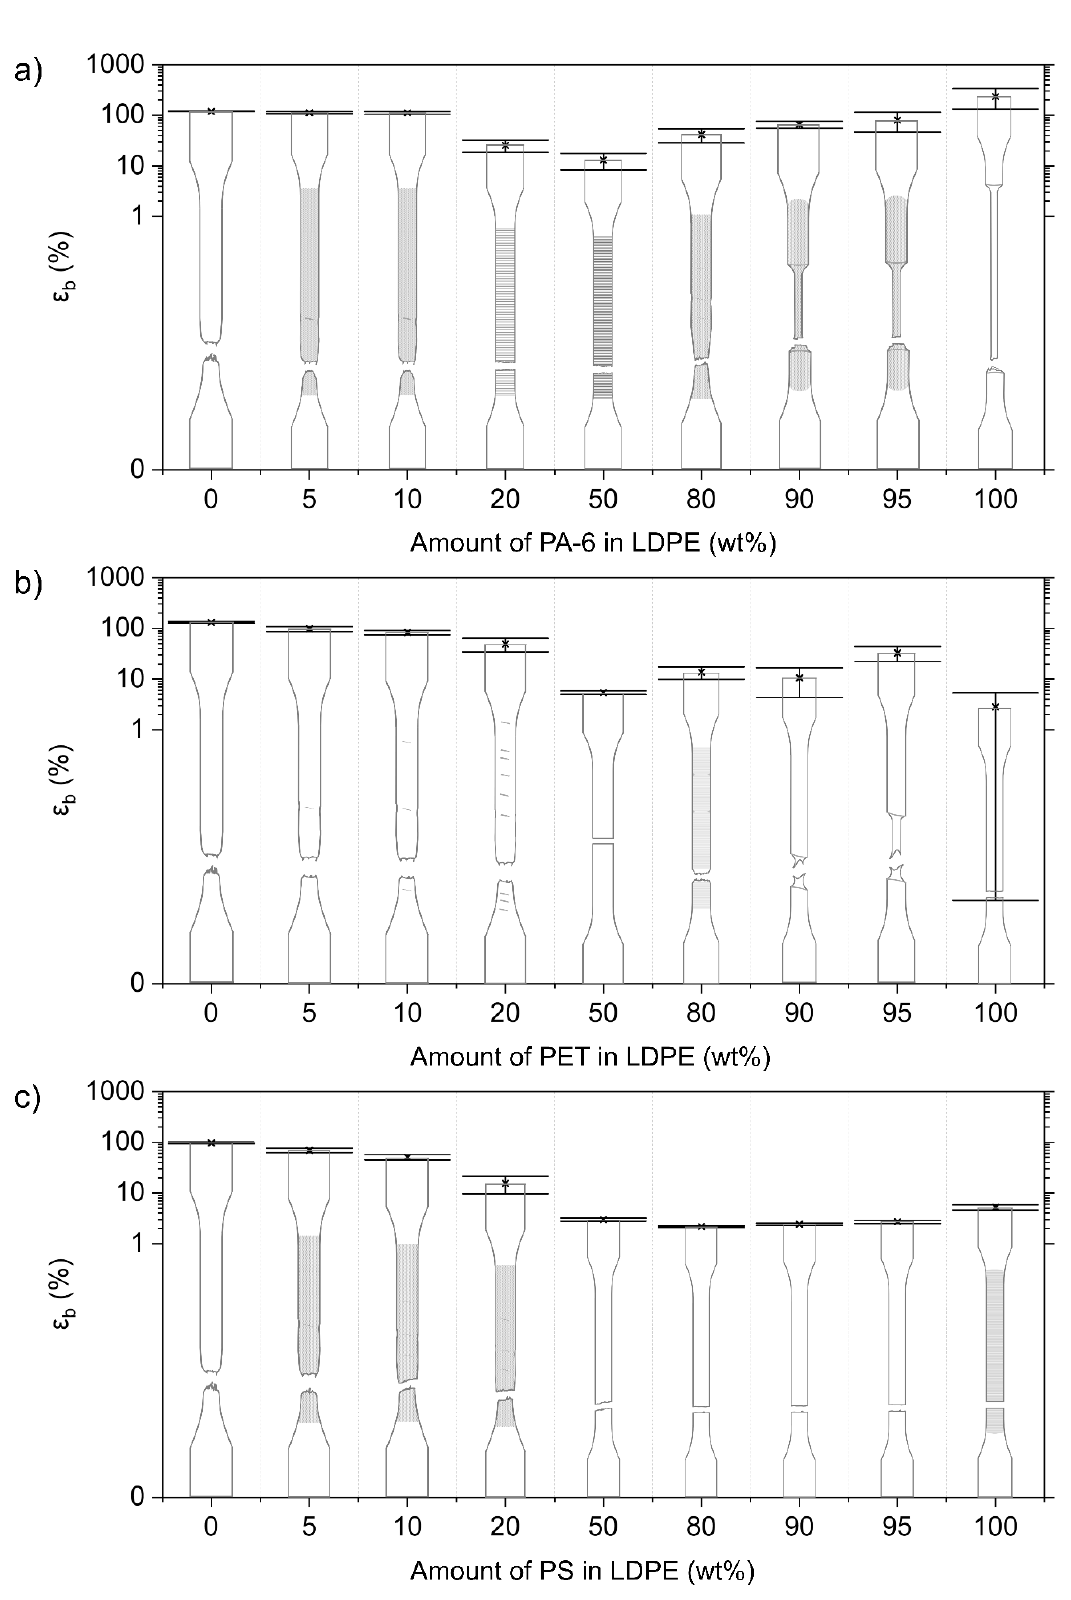
Figure 5. Overview of the deformed samples after tensile testing and respective ε b values for the LDPE blends combined with ( a ) PA-6, ( b ) PET, and ( c ) PS. Crazing is indicated as fine mark lines for the neat PS. Other shading points to stress whitening, which is visible during/after tensile testing. Coarser markings and lines indicate local points of necking initiation.